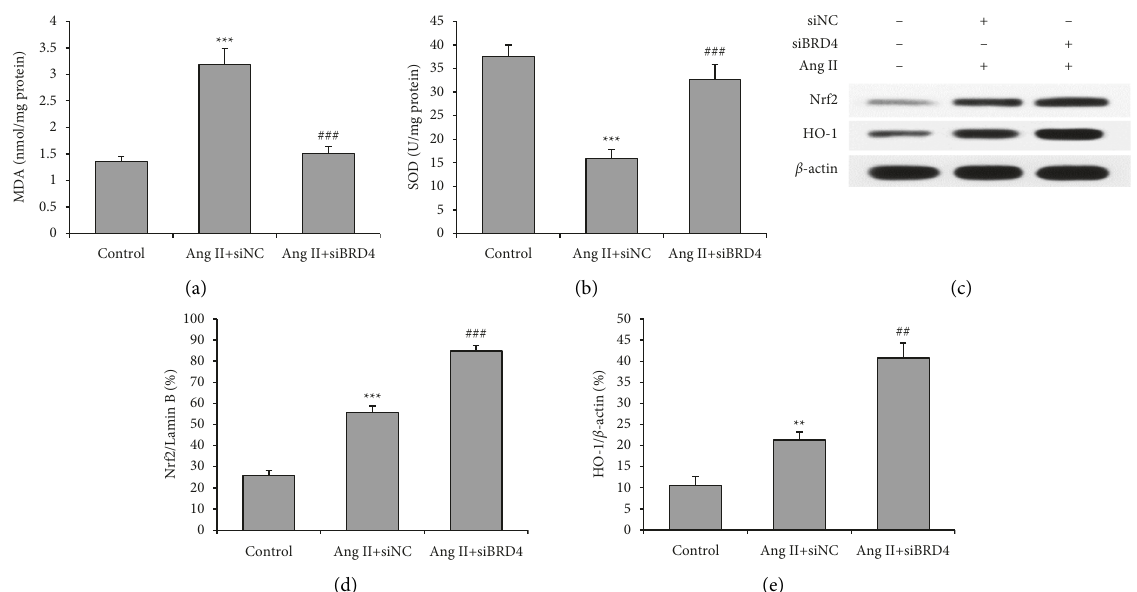
Figure 3: siBRD4 suppresses Ang II-induced oxidative stress in H9c2 cells by upregulating Nrf2 and HO-1. Respective commercial kits examined the MDA level (a) and SOD activity (b) in the control group, Ang II +siNC group, and Ang II+siBRD4 group. (c) The nuclear Nrf2 and total HO-1 protein levels were determined using a Western blot, and the representative protein bands are shown. siBRD4 increased the nuclear Nrf2 (d) expression and HO-1 (e) in H9c2 cells with Ang II stimulation. Each experiment was performed in triplicate and repeated at least three times. ∗∗ P < 0 . 01, ∗∗∗ P < 0 . 001 vs. control group; ## P < 0 . 01, ### P < 0 . 001 vs. Ang II+siNC group.